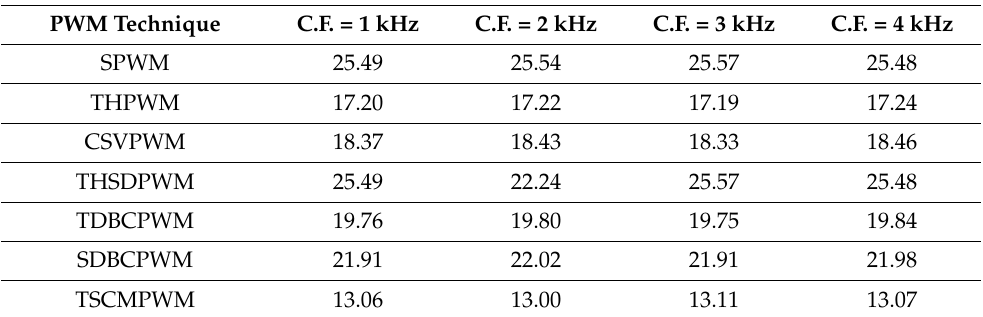
Table 3. Line voltage THDs of different pulse width modulation (PWM) techniques for carrier frequency variation.